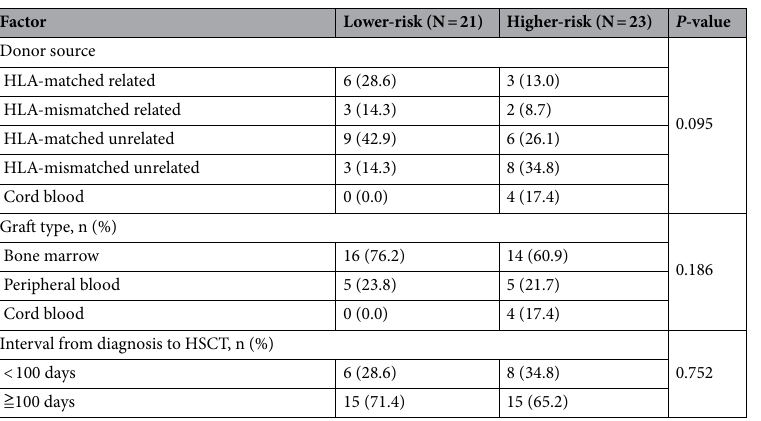
Table 2. Transplant recipient characteristics. AML acute myeloid leukemia, BM bone marrow, BU busulfan, CA cytarabine, CY cyclophosphamide, EB excess blasts, FAB French-American-British, FLU fludarabine, HCT-CI hematopoietic cell transplantation-specific comorbidity index, HMA hypomethylating agents, HLA human leukocyte antigen, HSCT hematopoietic stem cell transplantation, IPSS international prognostic scoring system, MEL melphalan, MLD multilineage dysplasia, NA not available, PC platelet concentrate, RA refractory anemia, RAEB refractory anemia with excess blasts, RARS refractory anemia with ringed sideroblasts, RBC red blood cells, RS ringed sideroblasts, SLD single lineage dysplasia, TBI total body irradiation. *Cytogenetic risks were stratified based on the Revised International Prognostic Scoring System (IPSS-R) score 22